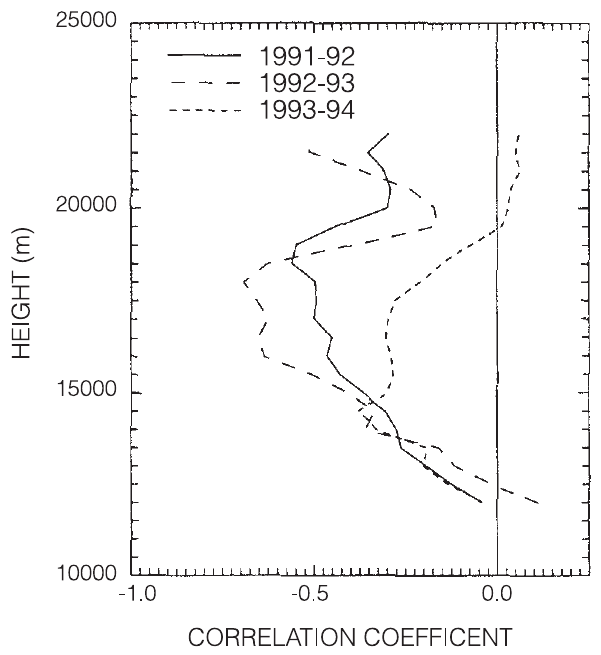
Fig. 5. Average correlation coeffi cient between the aerosol and ozone deviations as a function of height for the winters 1991-1992, 1992-1993 and 1993-1994 (di Sarra et al. ,